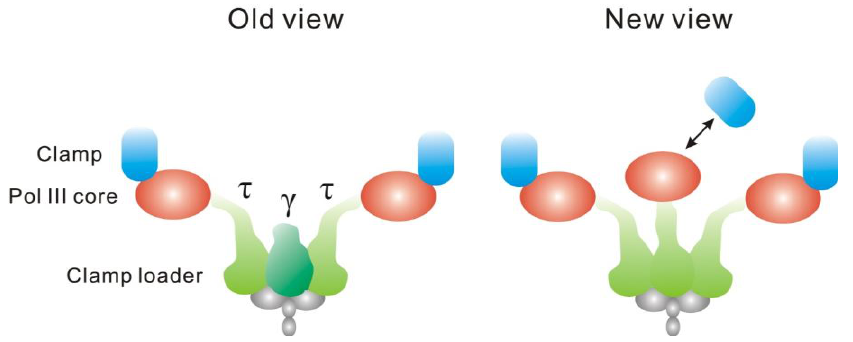
Figure 7. Models for replisome composition/architecture. The old view is based on